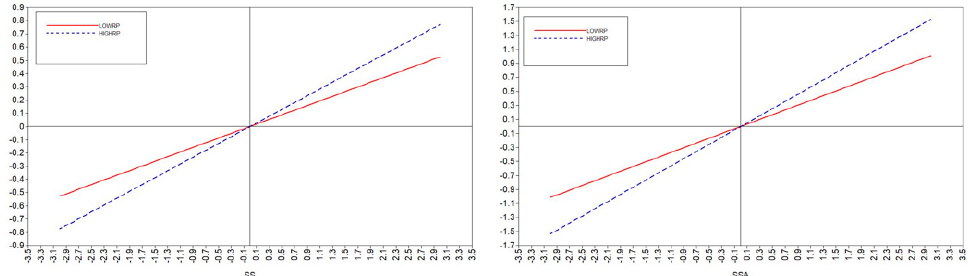
Figure 4. The moderating effect of psychological resilience on the relationship between social support and positive coping styles.